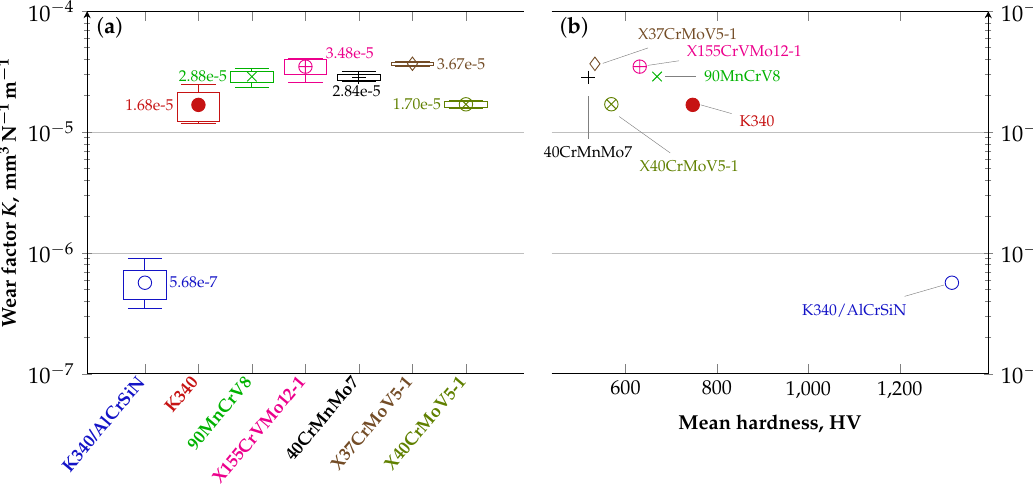
Figure 5. Diagram illustrating the wear factor K : ( a ) for the tested materials and ( b ) as a function of surface hardness. surface